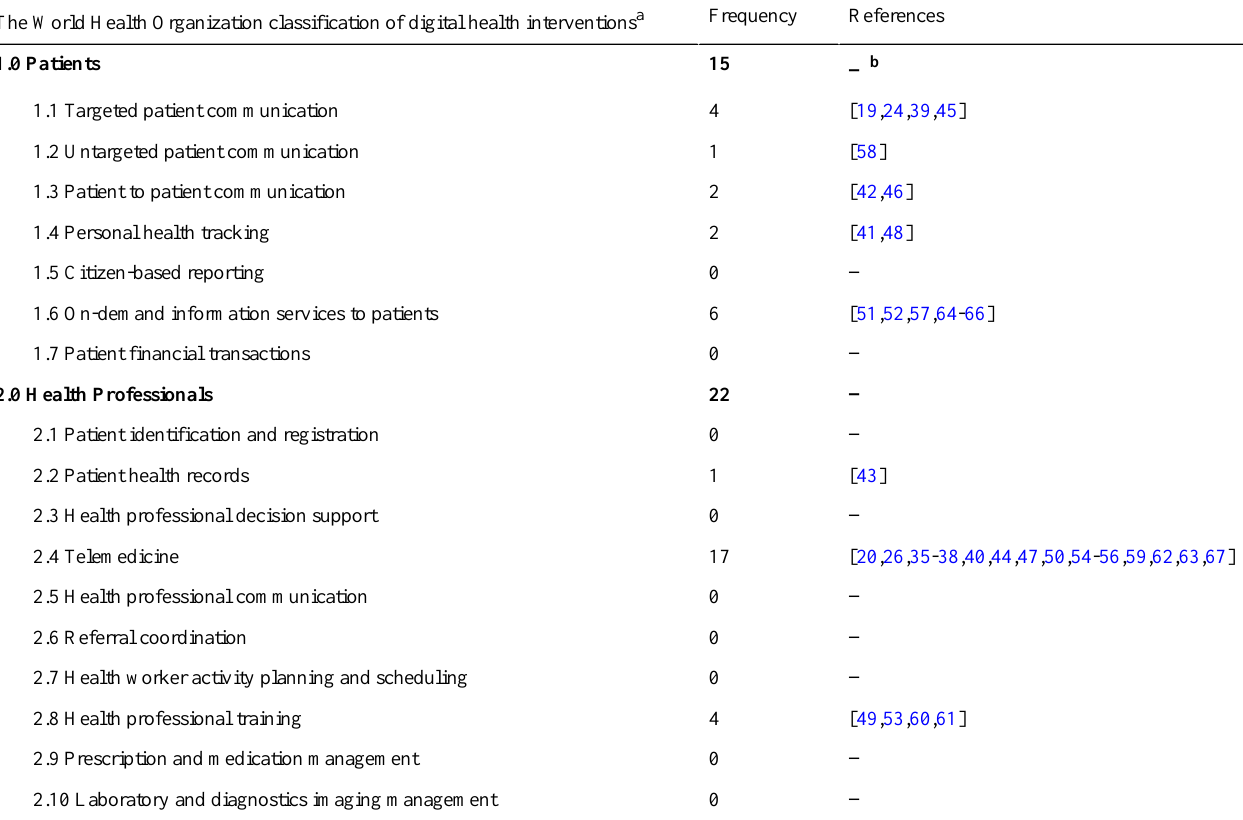
Table 2. Digital health